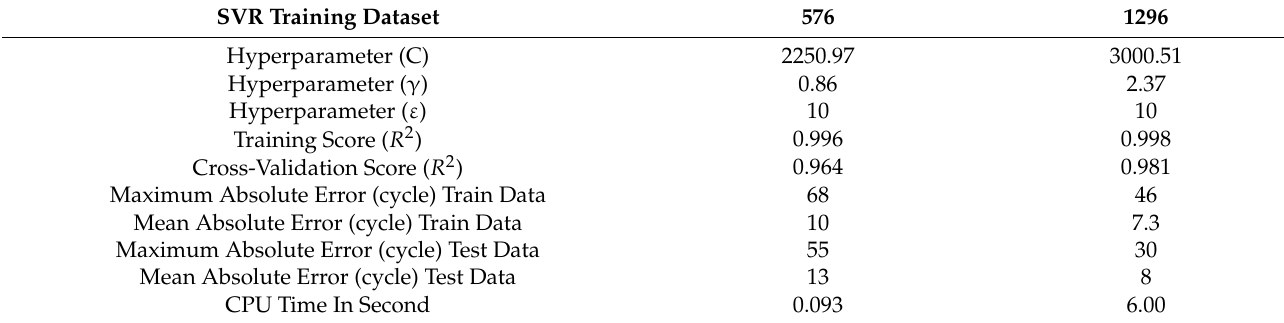
Table 15. SVR result